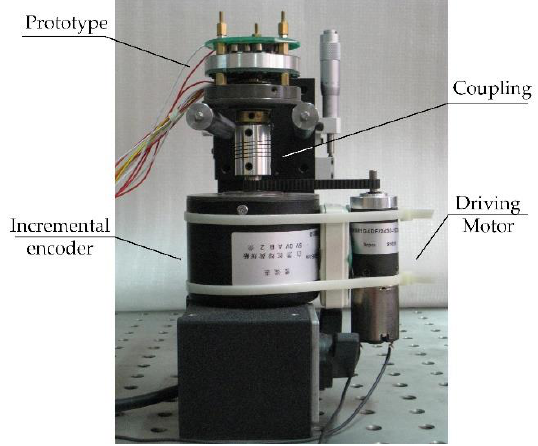
Figure 9. Experimental system.